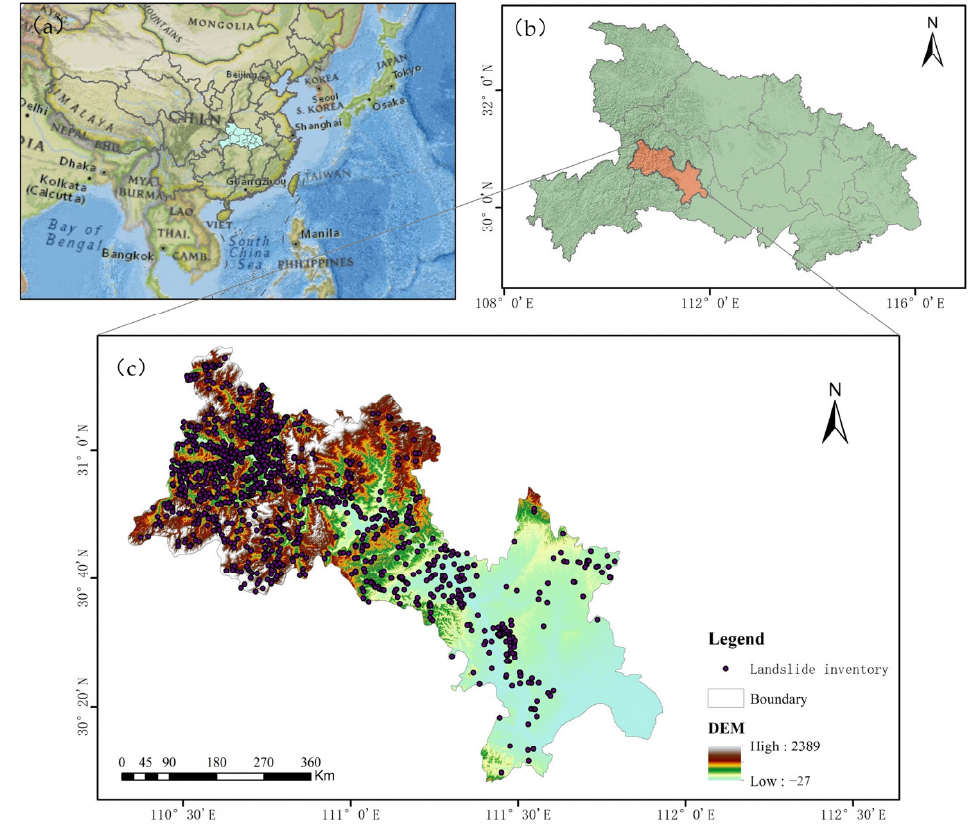
Figure 2. Geographical location of the study area. ( a ) Hubei Province in China; ( b ) Study area in the Hubei Province; ( c ) Yangtze River in the Yichang City.